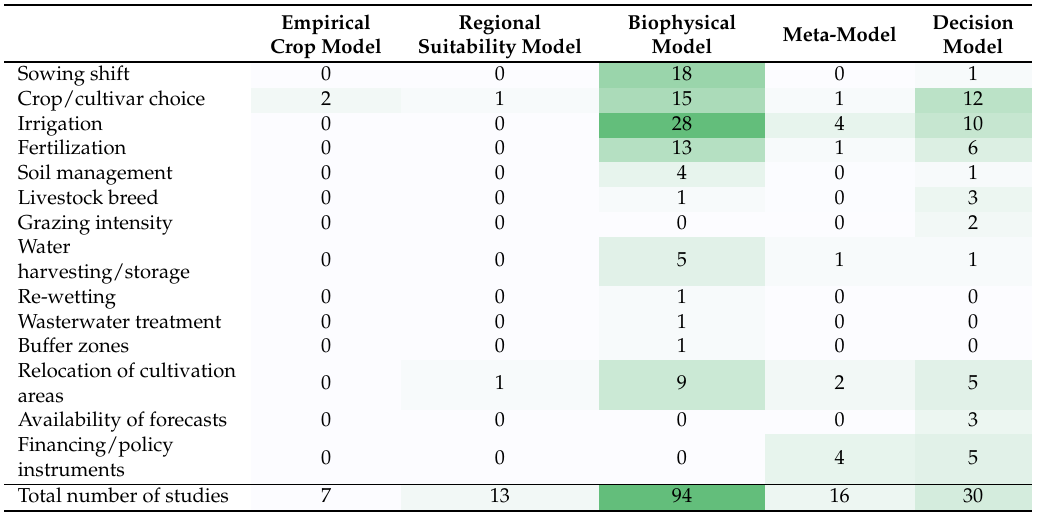
Table 2. Number of modelling studies explicitly simulating different adaptation options with each of the five identified model